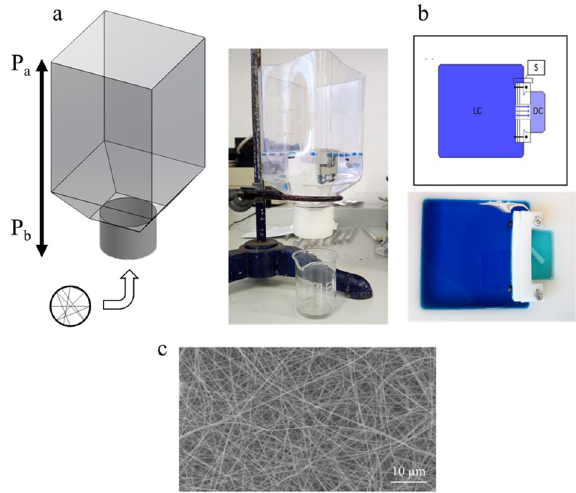
Figure 1. Mechanical and physical characterization of the electrospun gelatin structure (a) Permeability test set-up. P a represents the water pressure and P b the atmospheric pressure. (b) Diffusion test set-up. The large chamber (LC) was filled with methylene blue and the diffusion chamber (DC) with deionized water. Reproduced with permission 25 . Copyright 2015, Journal of Biomedical Materials Research . (c) SEM image of the electrospun gelatin structure (× 2000